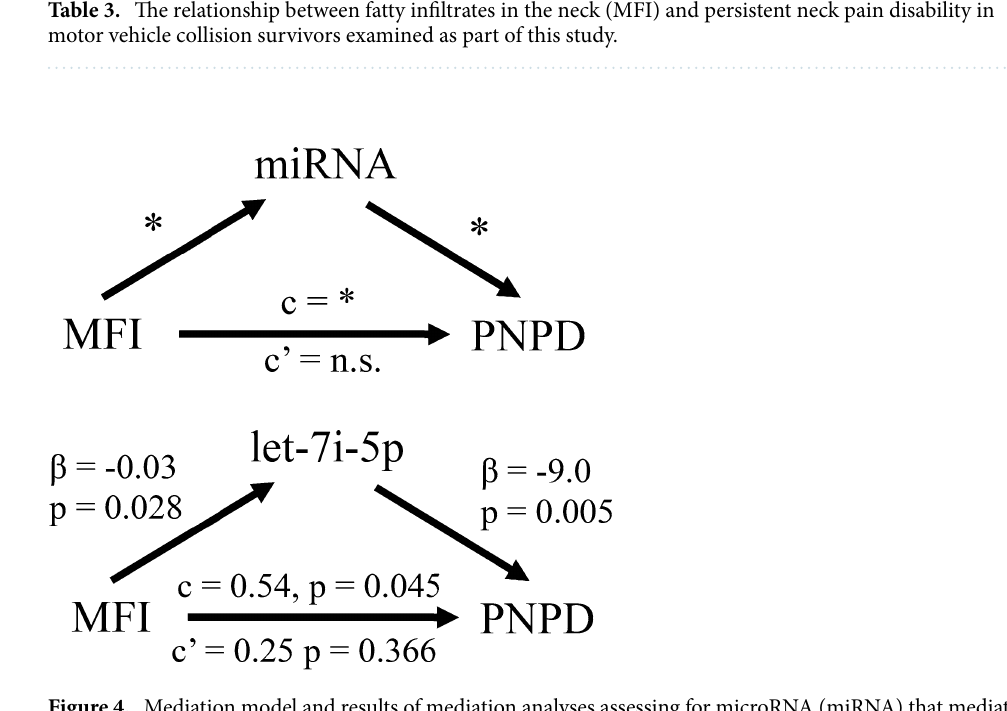
Figure 4. Mediation model and results of mediation analyses assessing for microRNA (miRNA) that mediate the relationship between fatty infiltrates of the neck muscle (MFI) and persistent neck pain disability (PNPD). Top : Schematic of the mediation model used to assess whether a particular miRNA or set of miRNA transcripts might mediate the relationship between MFI and PNPD development following motor vehicle collision trauma. “c” refers to the total effect in the unmediated model and “c’ ” refers to the direct effect in the mediation model. We assessed for complete mediation (versus partial) thus were interested in miRNA transcripts that caused MFI to no longer affect PNPD (i.e. “n.s.”) upon addition of the miRNA transcript to the model. Bottom : MFI relationship with let-7i-5p (leftmost arrow), let-7i-5p relationship with PNPD (rightmost arrow), and